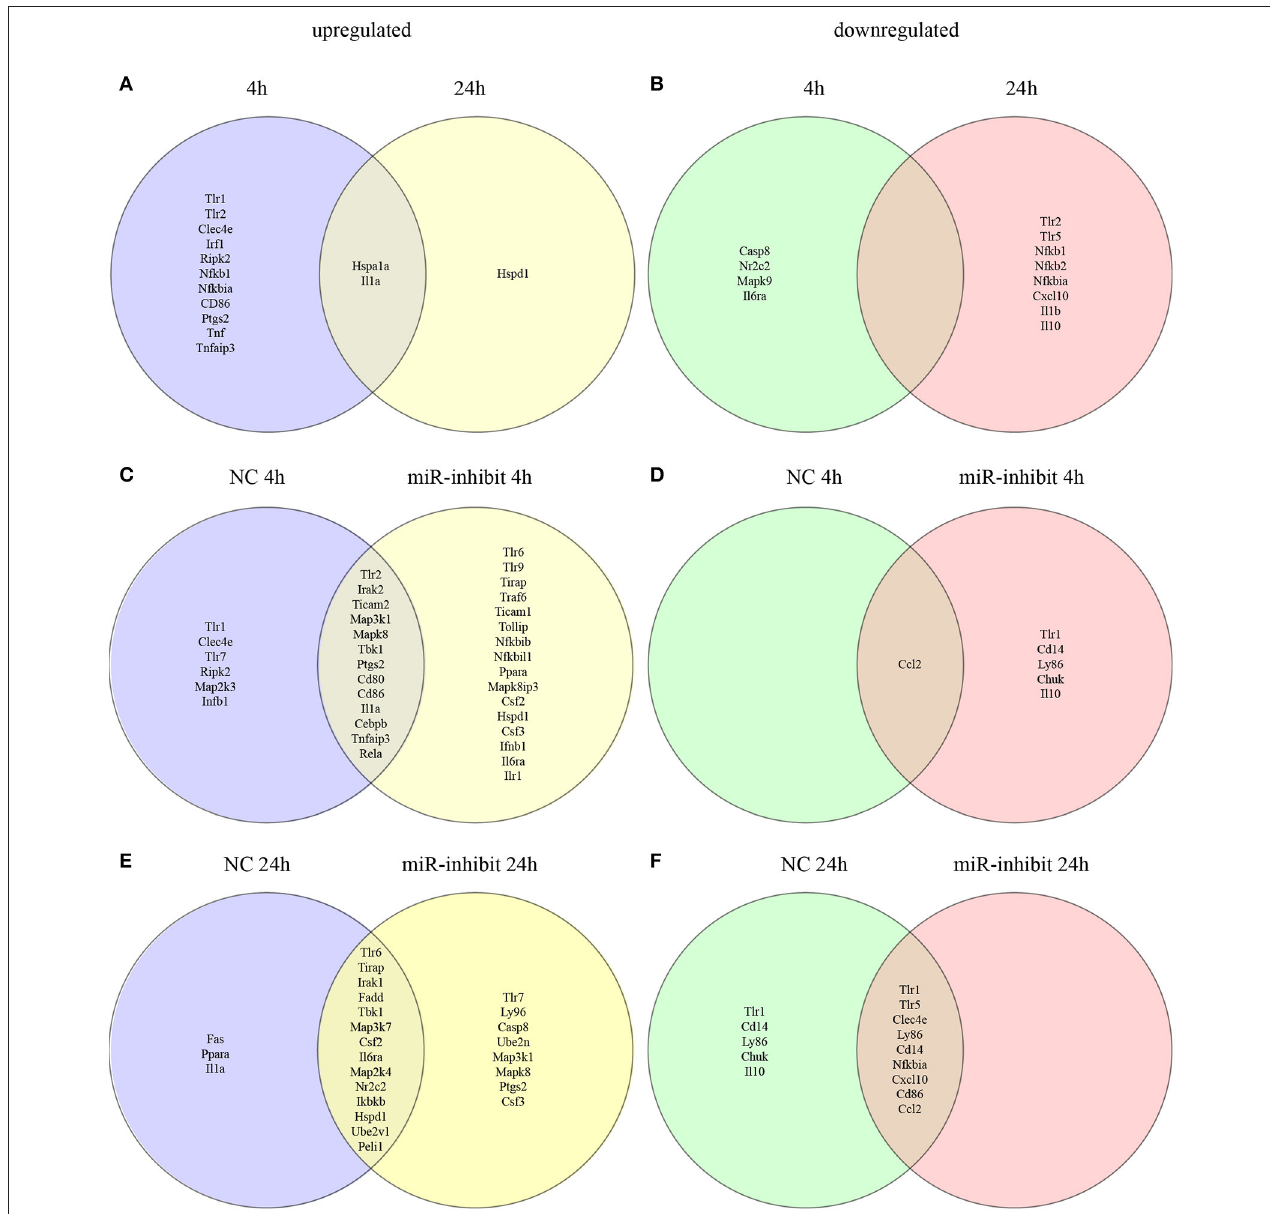
FIGURE 6 | Venn diagram depicting unique and common mRNAs in the TLR pathway and cytokines that were significantly differentially expressed in response to let-7e inhibition in L. amazonensis -infected macrophages. BMDMs were transiently transfected with 100nM negative control (NC) or let-7e-5p inhibitor (let-7e). Twenty-four hours after transfection, cells were co-cultivated with L. amazonensis (MOI 5:1) for 4h, and the cultures were then washed. After 4 and 24h of infection, cells were analyzed for the expression of mRNAs in the TLR signaling cascade, using RT-qPCR. The upregulated (A) and downregulated (B) mRNAs were compared at 4 and 24h after infection. Comparison of mRNA expression in NC- and let-7e inhibitor-transfected cells: upregulated at 4h (C) or 24h (D) or downregulated at 4h (E) or 24h (F) . The relative up- and downregulation of miRNAs are presented as boundaries of 1.2 or − 1.2 of Fold Regulation, respectively. P -value < 0.05.